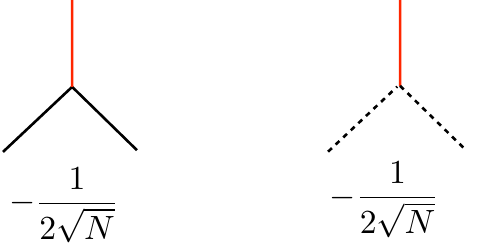
Figure 5 . The vertices for the e(cid:11)ective Lagrangian (2.42). The (cid:12)rst one represents the ~ (cid:31)(cid:24) 2 coupling, while the second one represents the ~ (cid:31)(cid:17) 2